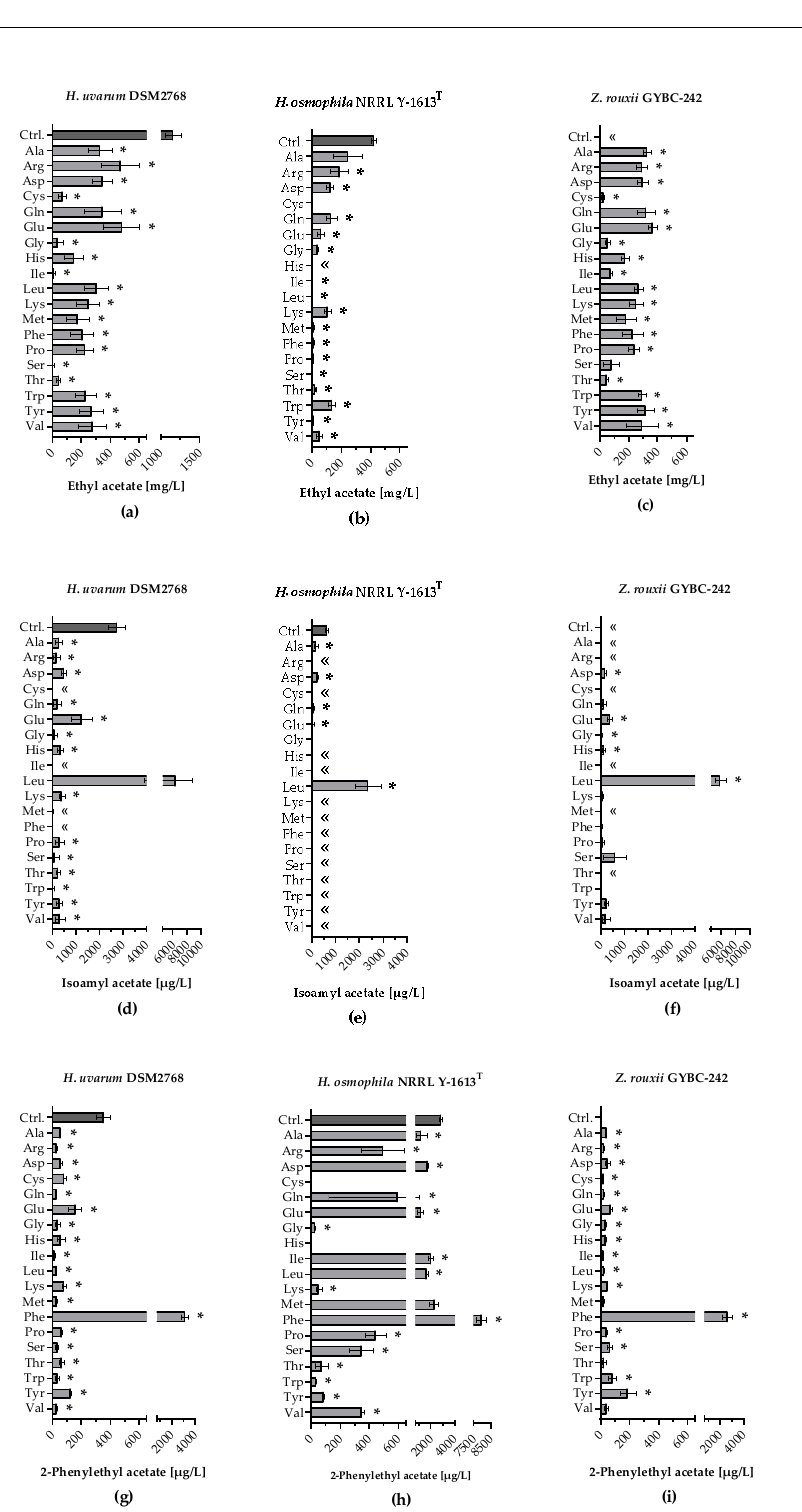
Commented [M1]: Change figure 5